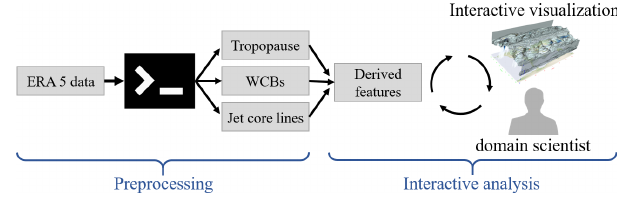
Figure 7. Our pipeline consists of two steps: a pre-processing that calculates the tropopause, WCB, and jet core-line geometries using a command line tool, and an interactive analysis in which the user interactively explores the correlation of those features in